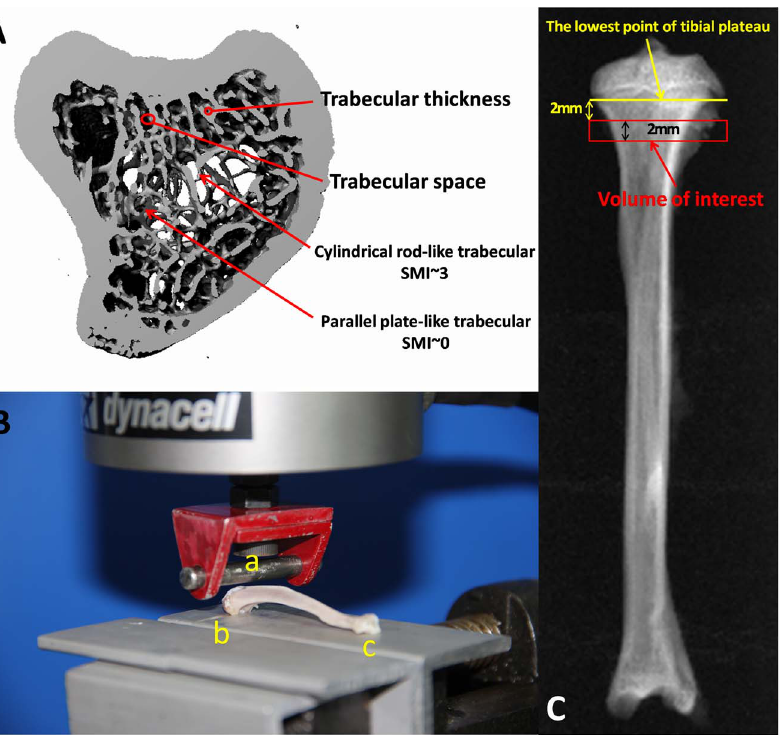
Figure 1. General introduction of the experimental methods of m CT and the three-point bending test. (A) Experimental parameters of the rat tibia scanned using m CT. (B) Details on the experimental design of the three-point bending test consisting of an aluminum block and rounded edge-free notches. (C) The volume of test samples using m CT and the three-point bending test.